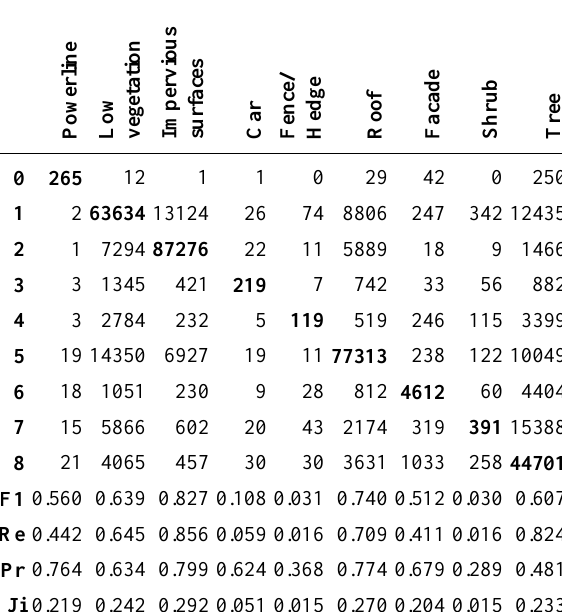
Table 4. Error matrix for best TF and accuracy indices (eq. 6) – column headers are class labels, row names are respective class indices.